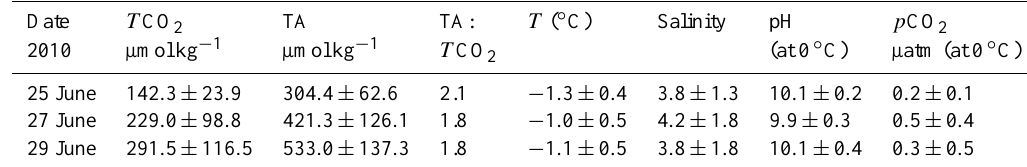
Table 2. Sea ice meltwater conditions of temperature, salinity, T CO 2 , TA and p CO 2 during the field campaign. Values are mean ± standard deviation ( n = 10) of vertical profile data from sea ice cores collected on the respective dates with p CO 2 conditions calculated at 0dbar and 0 ◦